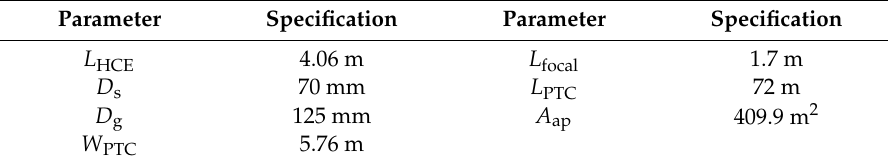
Table 2. Specifications of studied HCE and parabolic trough collector (PTC)